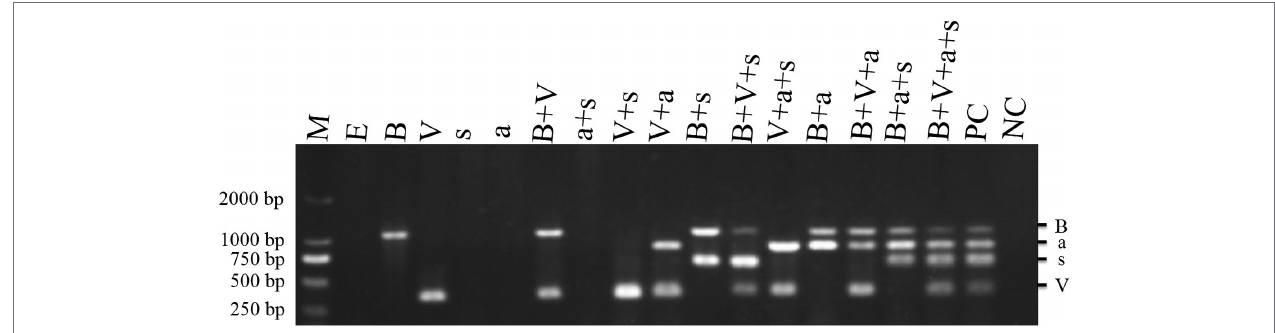
FIGURE 4 | RT-PCR detections of TBTD causal agents in the assayed tobacco K326 plants at 14 dpi. Lanes M, DL 2000 DNA Marker; lane E, plants inoculated with pCB301; lane B, plants inoculated with TBTV-YK; lane V, plants inoculated with TVDV-YK; lane s, plants inoculated with TBTVsatRNA-YK; lane a, plants inoculated with TVDVaRNA-YK; lane B+V, plants inoculated with TVDV-YK+TBTV-YK; lane a+s, plants inoculated with TVDVaRNA-YK+TBTVsatRNA-YK; lane V+s, plants inoculated with TVDV-YK+TBTVsatRNA-YK; lane B+s, plants inoculated with TBTV-YK+TBTVsatRNA-YK; lane V+a, plants inoculated with TVDV- YK+TVDVaRNA-YK; lane V+B+s, plants inoculated with TVDV-YK+TBTV-YK+TBTVsatRNA-YK; lane V+a+s, plants inoculated with TVDV-YK+TVDVaRNA- YK+TBTVsatRNA-YK; lane B+a+s, plants inoculated with TBTV-YK+TVDVaRNA-YK+TBTVsatRNA-YK; lane V+B+a+s, plants inoculated with TVDV-YK+TBTV- YK+TVDVaRNA-YK+TBTVsatRNA-YK. PC, Positive control; NC, negative control using healthy tobacco K326 plant